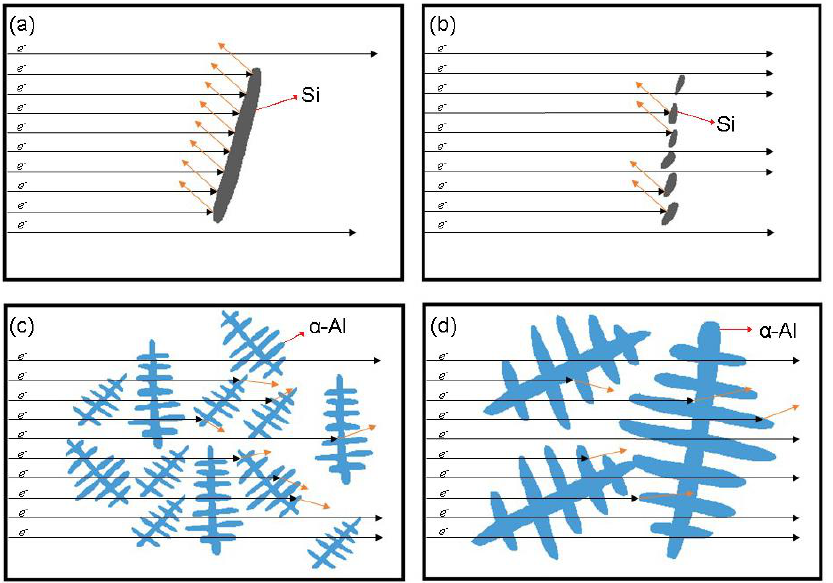
Figure 6. Schematic diagrams of electrons being scattered by: ( a ) eutectic silicon particles under a slower cooling rate, ( b ) eutectic silicon particles under a faster cooling rate, ( c ) α-Al grain boundary under a faster cooling rate, and ( d ) α-Al grain boundary under a slower cooling rate.